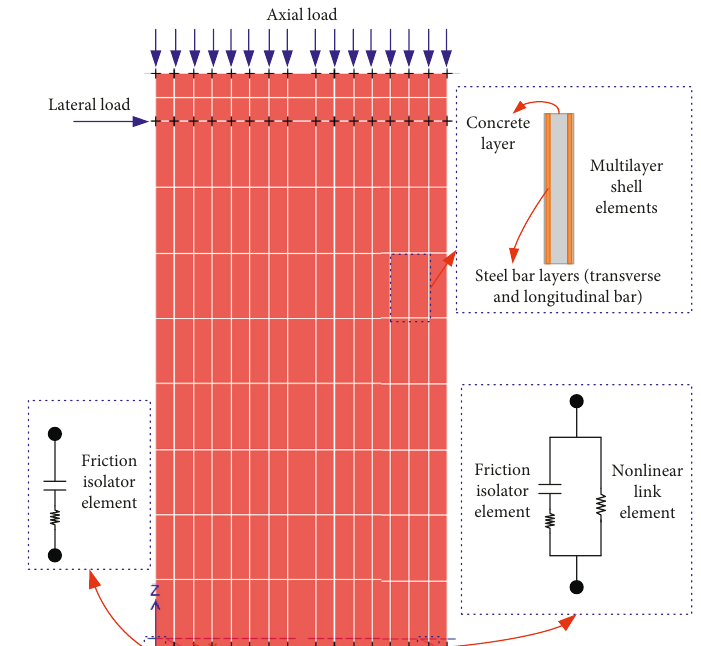
Figure 21: Modeling based on ETABS.